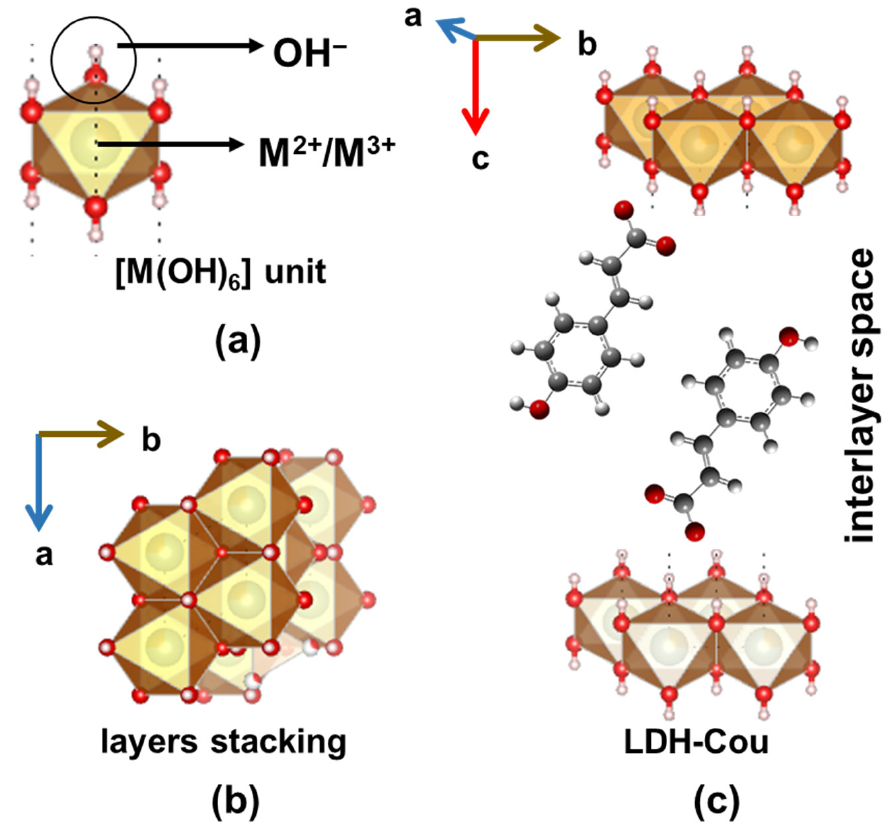
Figure 1. Schematic representation of ( a ) basic octahedral unit in the LDH layers; ( b ) [M(OH) 6 ] units are joined by the edges forming layers in a stacked fashion, and ( c ) structure of LDH-Cou (Zn 2 Al-Cou) material. Fractions of LDH structure (ICSD number 91155) were obtained using the software Vesta version 3.